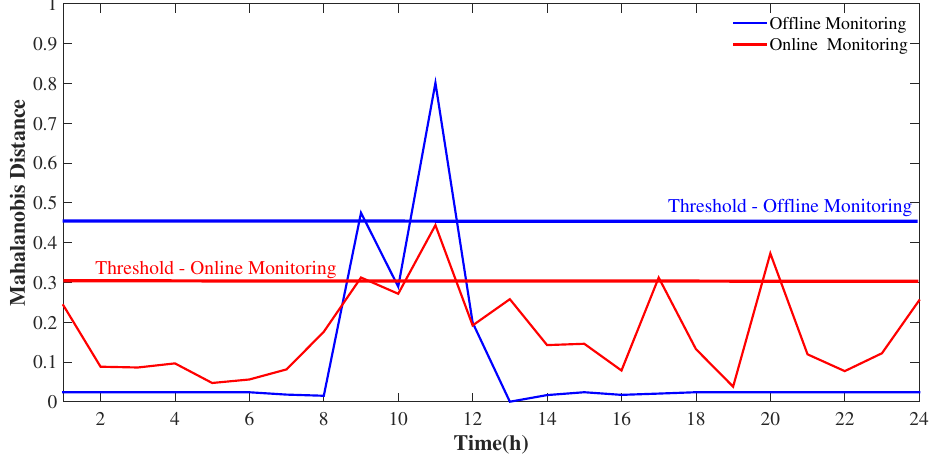
Figure 5. Online monitoring versus offline monitoring - Day #1.